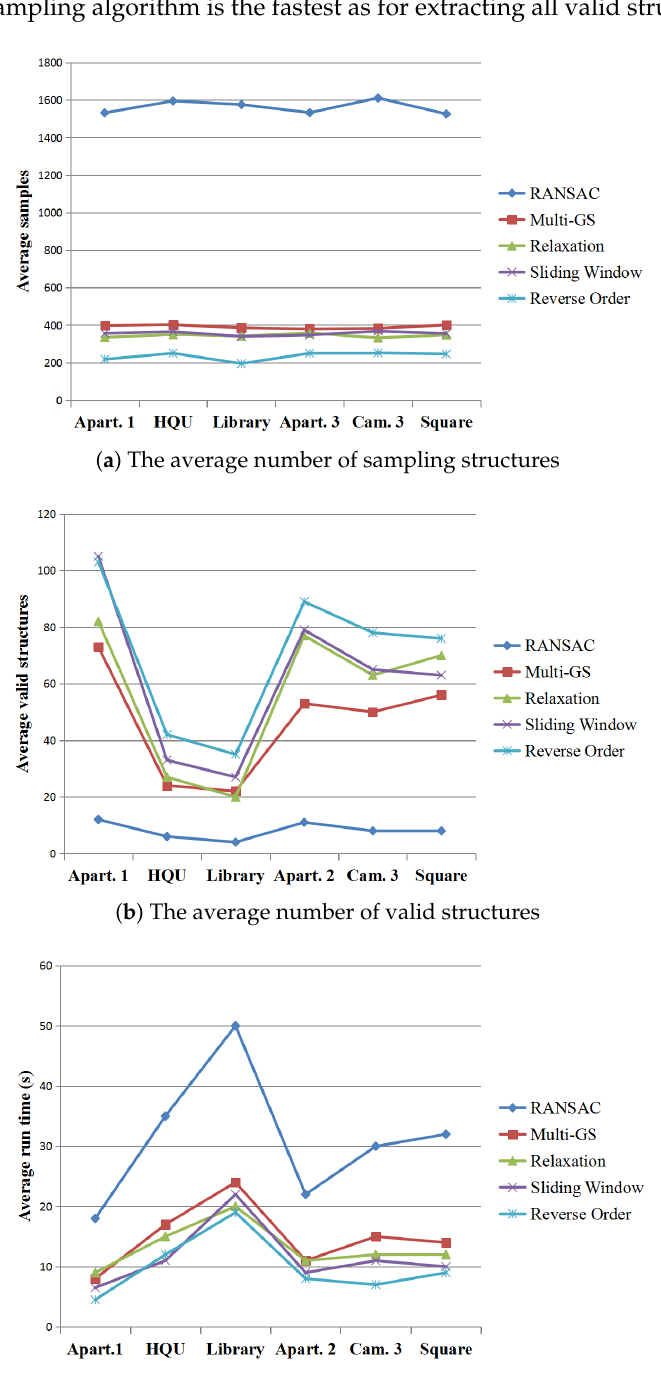
Figure 8. The average sampling structures, the average number of valid structures, and the run time of hitting all